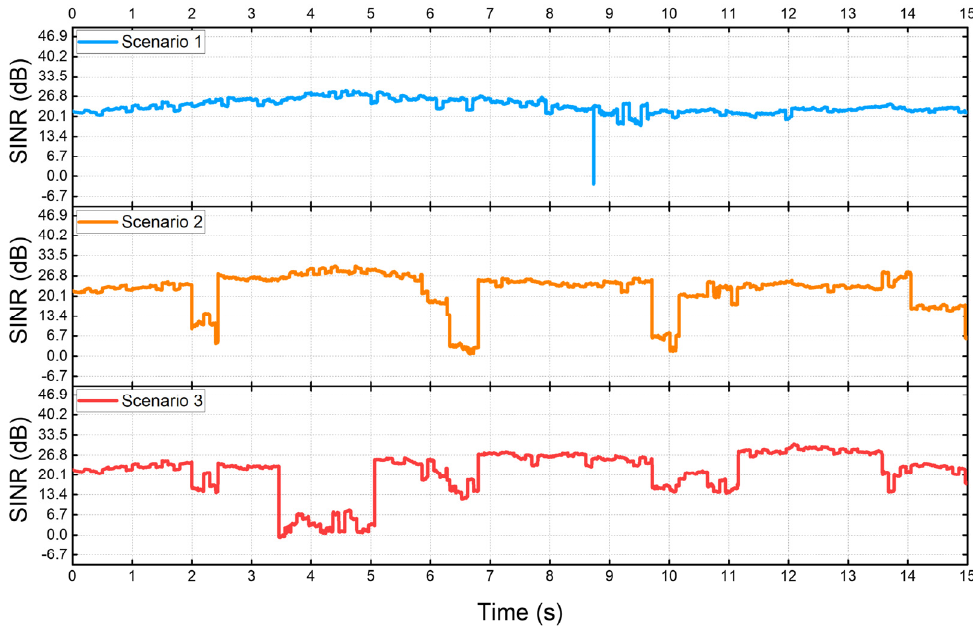
Table 1. Simulation parameters.